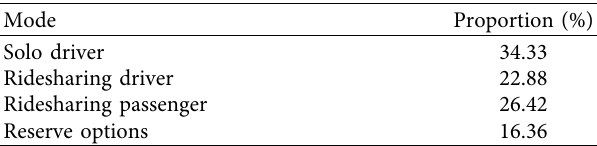
Table 3: Initial mode